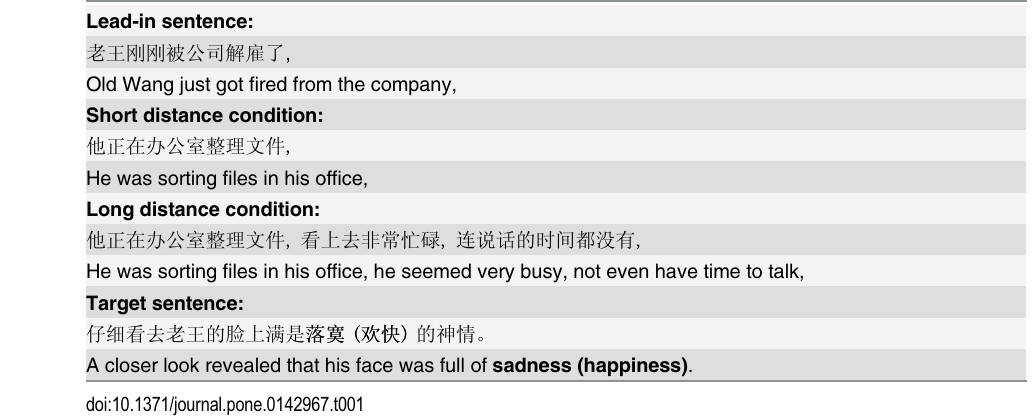
Table 1. Example stimuli used in the present